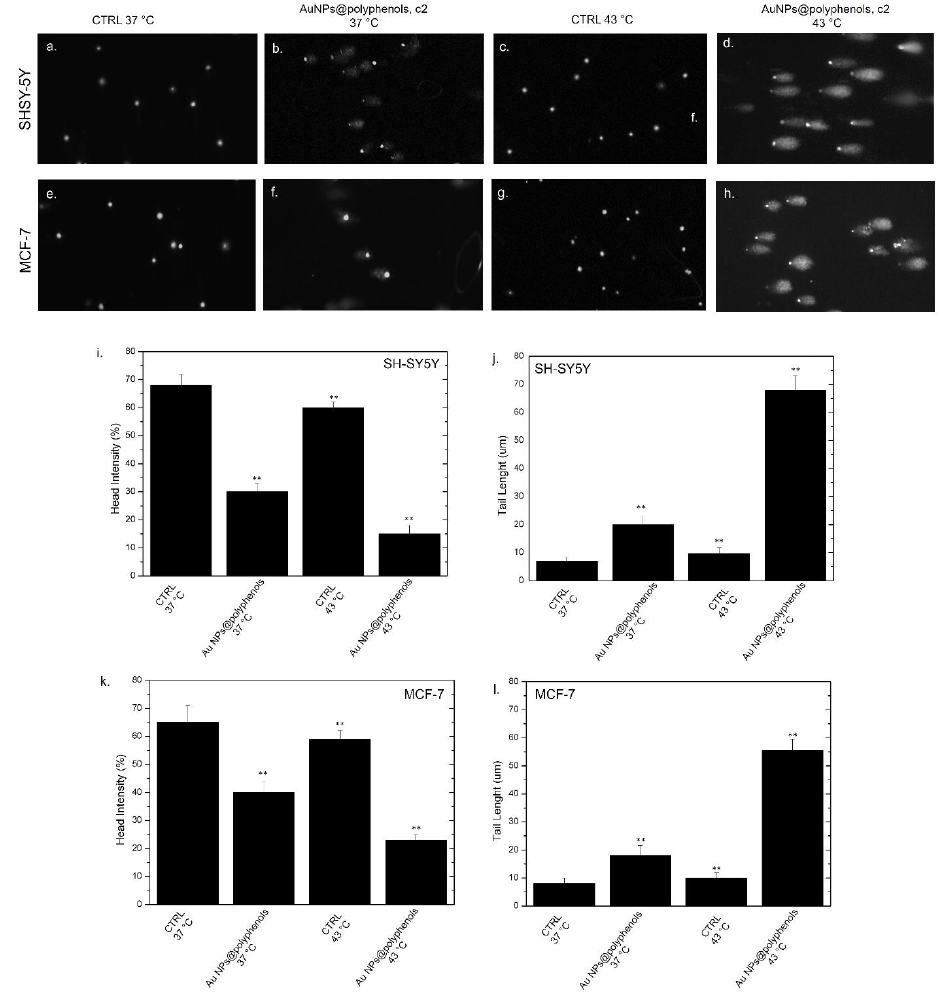
Figure 10. Representative images of DNA damage in SH-SY5Y ( a – d ) and MCF-7 ( e – h ). Untreated cells ( a , e ) exposed to AuNPs@polyphenols at the concentration of c2 at 37 °C ( b , f ), treated with 43 °C ( c , g ), and incubated with Au NPs@polyphenols at the concentration of c2 at 43 °C for 48 h. The DNA damage was evaluated by the head intensity (%) ( i , k ) and tail length (μm) ( j , l ). The values shown are the means from 100 randomly selected comet images of each sample. As a positive control, the cells were incubated with 500 μM of H 2 O 2 (data not shown). The data are reported as the mean ± SD from three independent experiments; * p < 0.05, ** p < 0.001 compared with control ( n = 3). A similar behavior was noted in the MCF-7 cells, but with slightly stronger effects. For example, the application of heat and NP incubation induced a reduction in the head intensity percentage (c.a. 25%) (Figure 10k) and an increase in the tail length of about 55% (Figure 10l), indicating DNA damage. Additionally, in this case, the thermal treatment did not stimulate evident damage in the control cells both at 37 °C and 43 °C, whereas a few adverse effects were measured after the uptake of Au NPs@polyphenols at 37 °C.